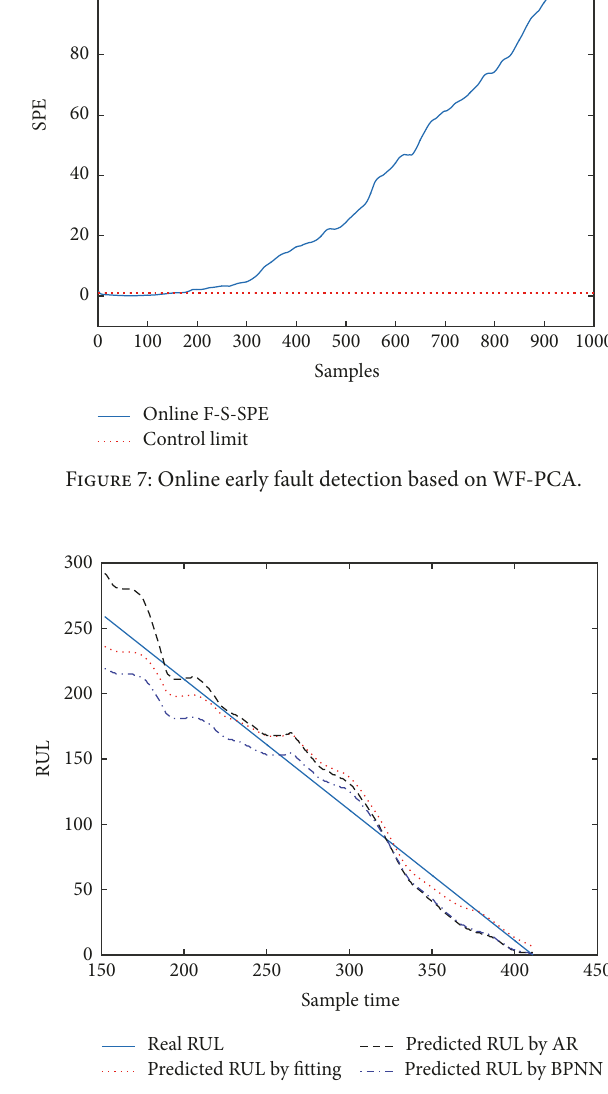
Figure 8: Online RUL prediction based on